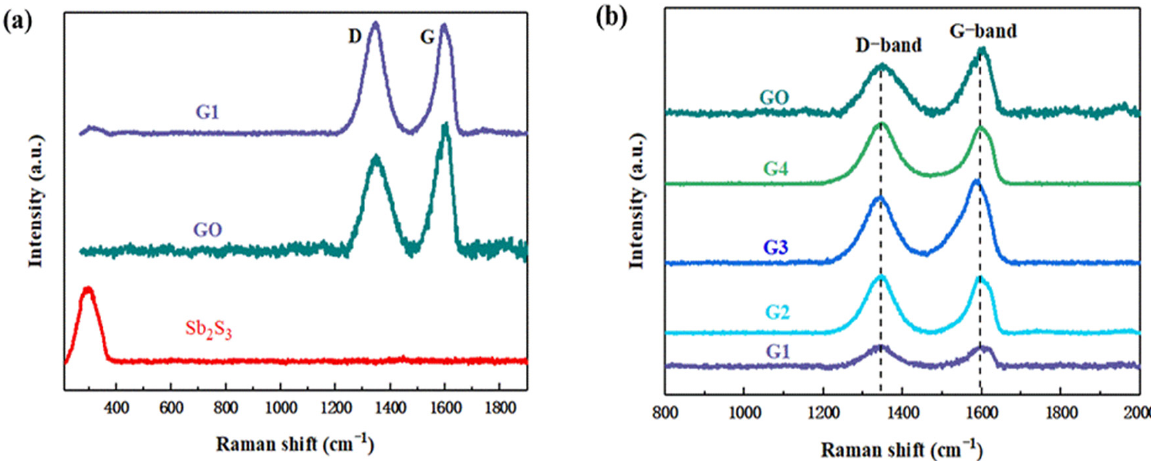
Figure 4. Raman patterns of GO, Sb 2 S 3 and G1 ( a ); Raman patterns of GO and composites G1–G4 ( b ).